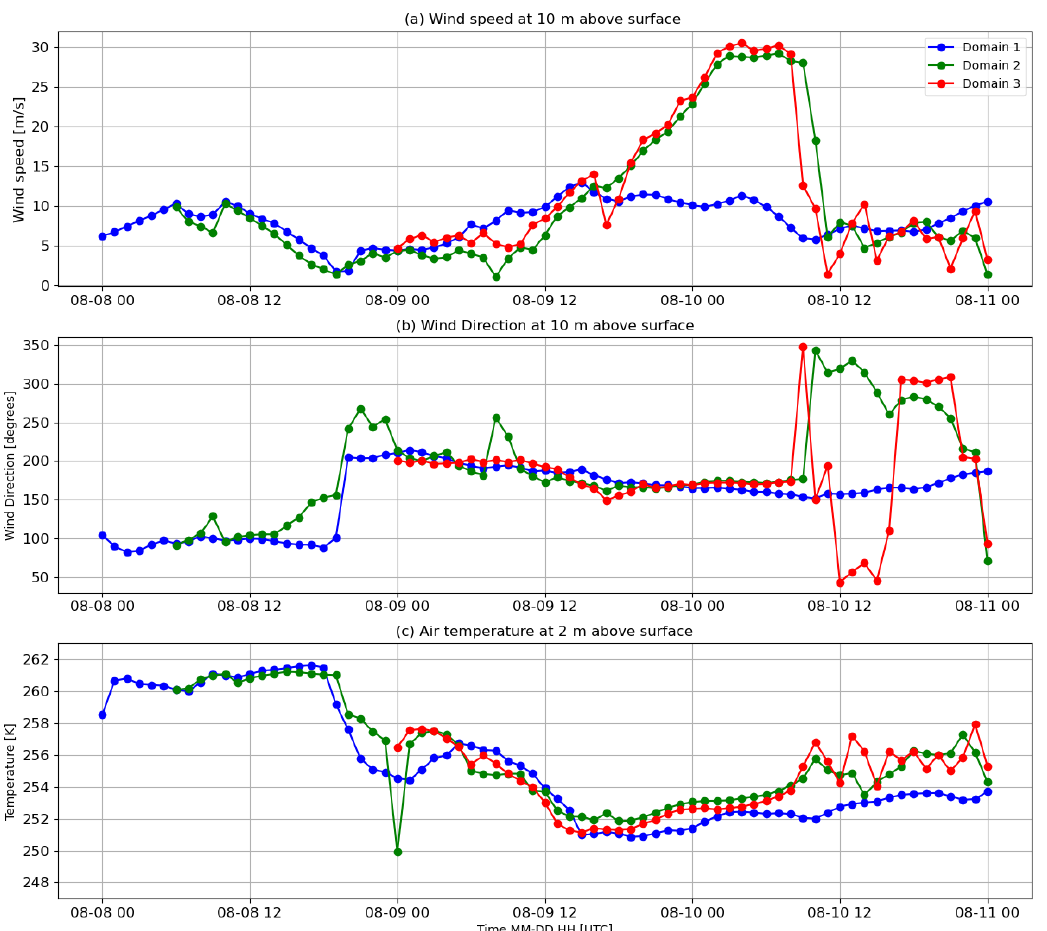
Figure 10. Meteorology at Dumont D’Urville as simulated by CRYOWRF. (a) Wind speed, (b) wind direction at 10m above surface, and (c) air temperature at 2m above